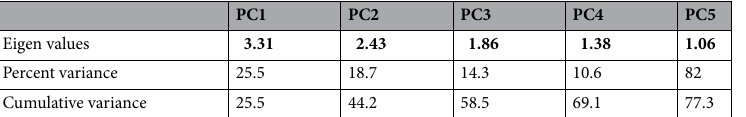
Table 2. Eigen values of first five principal components for seedling traits in 71 maize inbred lines under water deficit condition. Significant values are in [bold].